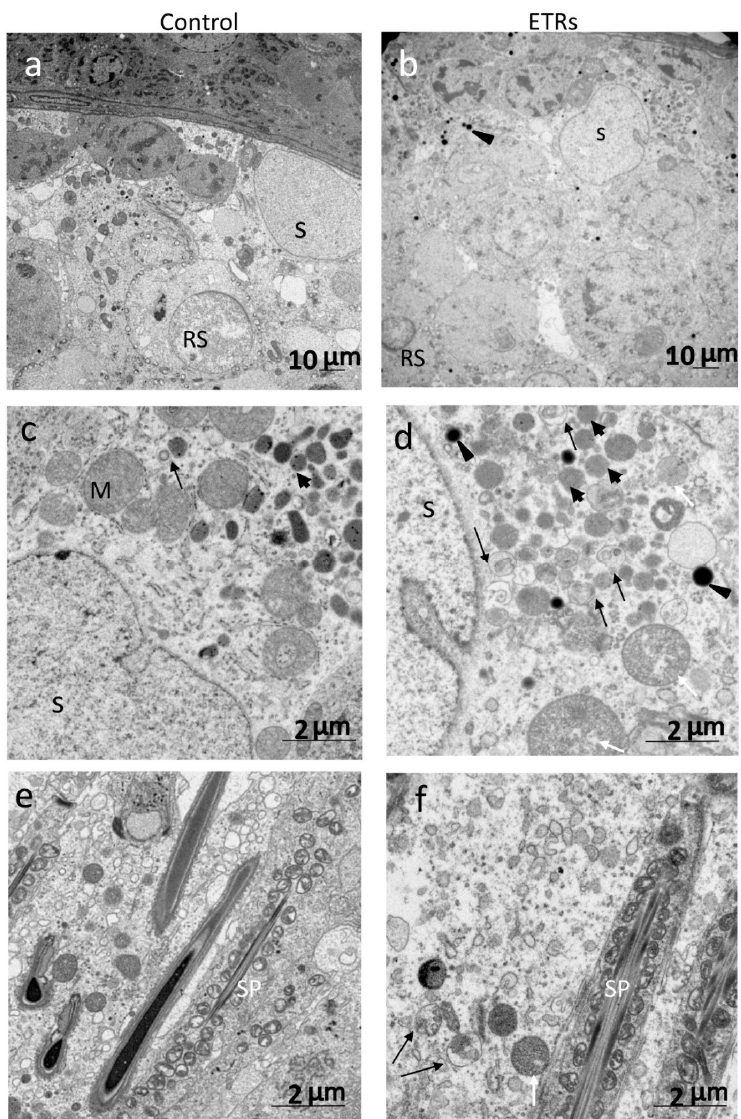
Figure 5. Ultrastructural features of enhanced autophagy in SCs of ETRs during stages VII–VIII. ( a , c , e : control testes; b , d , f : ETRs). The long black arrows indicate autophagic vacuoles (AVs) containing membranous structures, while the white arrows mark damaged mitochondria. The short black arrows and arrow heads show lysosomes and lipid droplets (LDs), respectively. RS: round spermatid; S: SC nucleus; SP: sperm; M: mitochondrion.